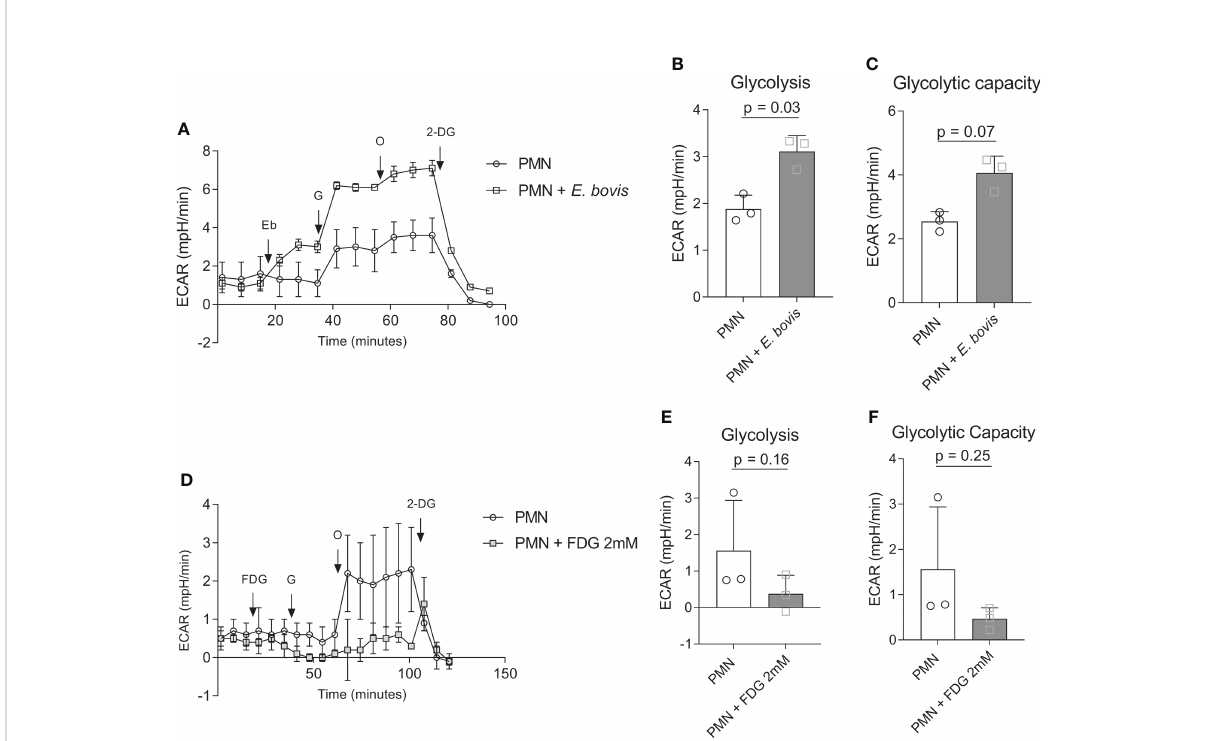
FIGURE 2 Glycolytic responses in E. bovis sporozoites-exposed bovine PMN. (A) Bovine PMN were resuspended in XF assay medium for glycolysis stress kit (Seahorse Bioscience). A total of 100,000 PMN were plated in eight-well XFp Agilent plates, and glycolytic responses were assessed as extracellular acidi fi cation rate (ECAR) after sequential injections of sporozoites (400,000), glucose (10 mM), oligomycin (1 µM; inhibits mitochondrial ATP synthase), and 2 ‐ DG (50 mM, blocks glycolysis). Arrows indicate injections of E. bovis sporozoites (Eb), glucose (G), oligomycin (O), and 2-deoxyglucose (2-DG) (B, C) . (D) Glycolytic response of FDG-treated bovine PMN. Extracellular acidi fi cation rate (ECAR) re fl ecting glycolytic responses were measured after serial injections (indicated by arrows) of FDG (2 mM, blocks glycolysis), glucose (activates glycolysis, 10 mM), oligomycin (0.1 m M, inhibits mitochondrial ATP synthase), and 2-deoxy-D-glucose (DG, 50 mM, blocks glycolysis); (E, F) Glycolytic parameters in FDG-treated and non-treated bovine PMN. All data are presented as mean ± SEM. p values were calculated by a paired two-tailed t-test analysis